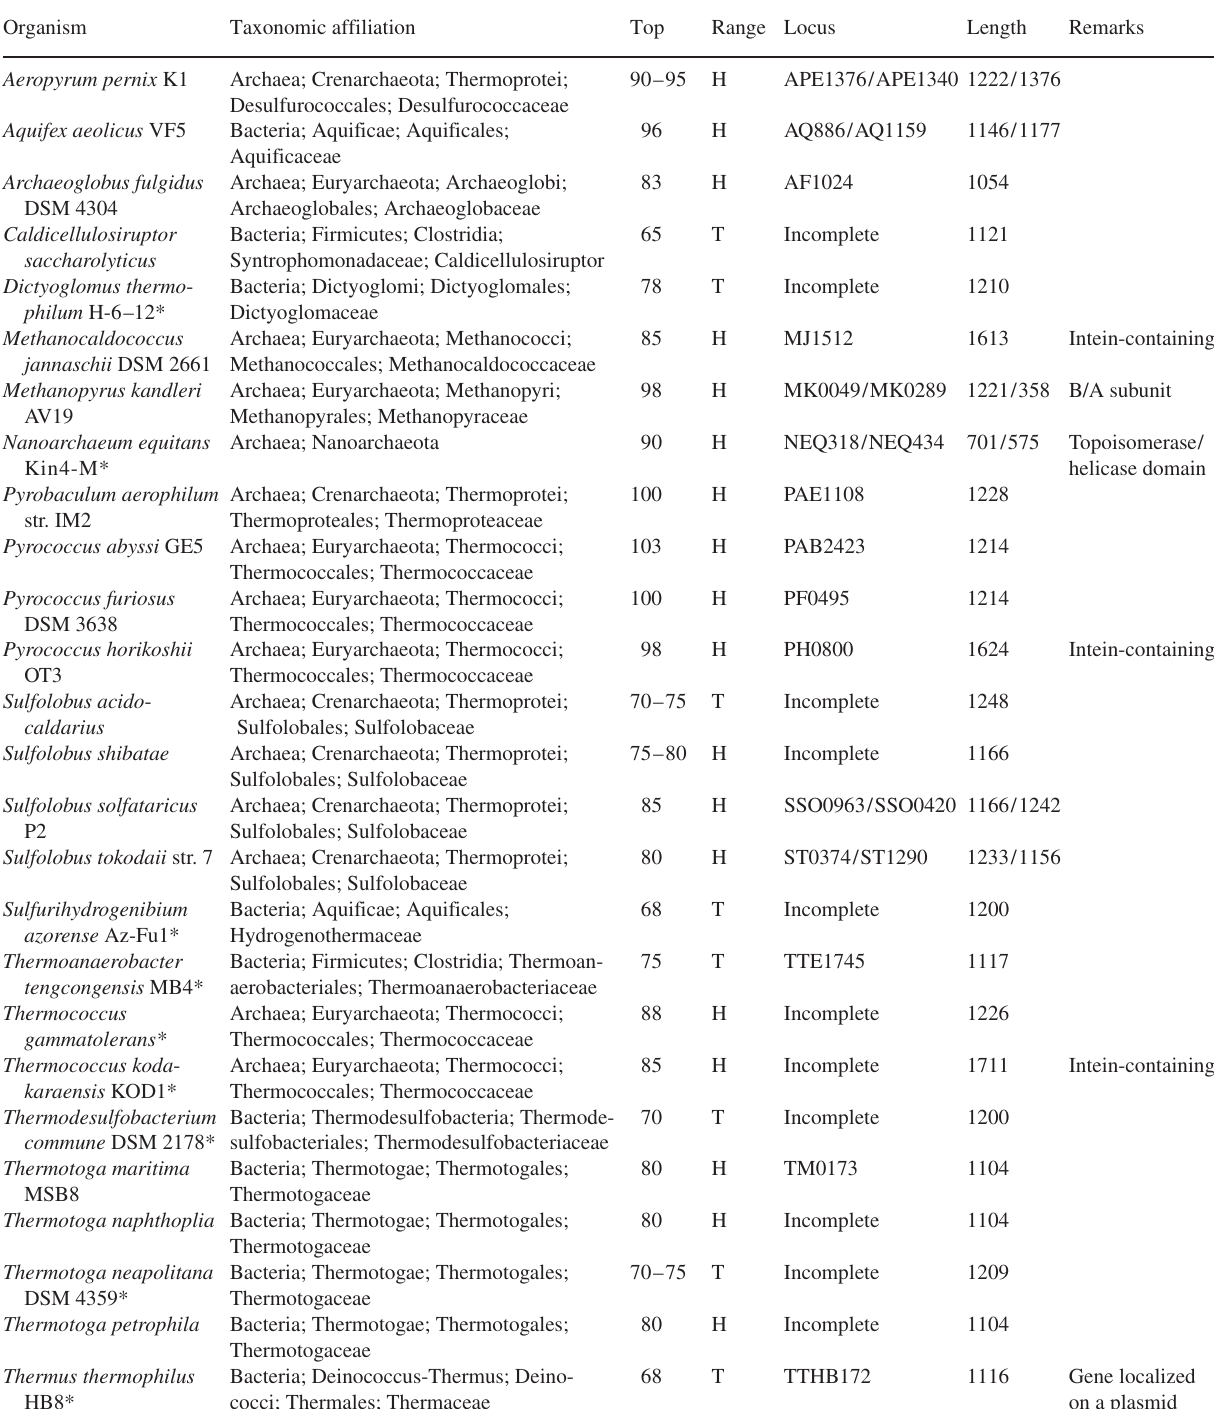
Table 1. Prokaryotes containing a gene coding for the reverse gyrase. The asterisk (*) indicates a new reverse gyrase found since our last study in 2002. Abbreviations: T = thermophilic; and H =